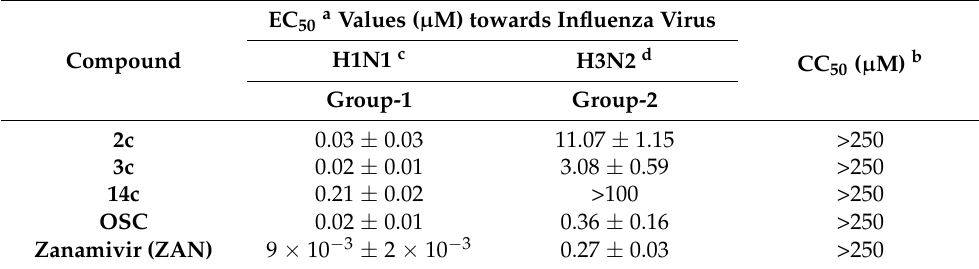
Table 3. Anti-influenza virus activity and cytotoxicity of oseltamivir derivatives in MDCK